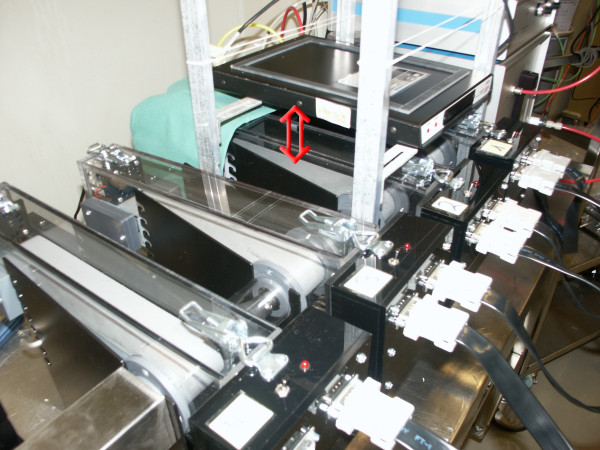
Treadmill with telemetry receiver plate. The arrow marks the distance between the running belt of the treadmill and the receiver plate. The secure fixation of the transmitter body on the back of the mouse allowed reliable, constant recording of blood pressure curves from mice during maximal exercise.